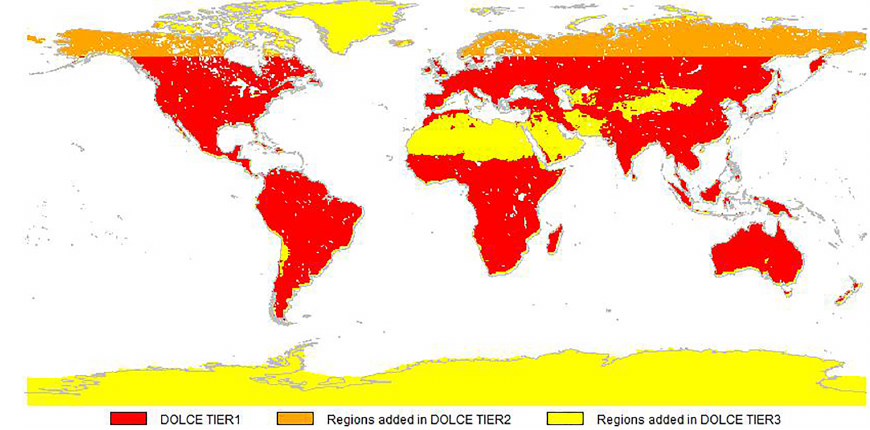
Figure 1. Spatial coverage of DOLCE tier 1 (red); regions added in tier 2 (orange) and tier 3 (yellow). Spatial coverage varies temporally; May 2000 is shown here as a representative example.